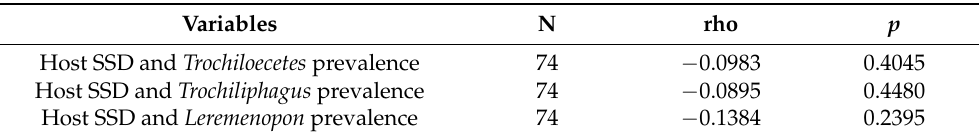
Table 5. Spearman rank correlations between the sexual size dimorphism (SSD) of host taxa (N ≥ 50 individuals) and the prevalence of louse